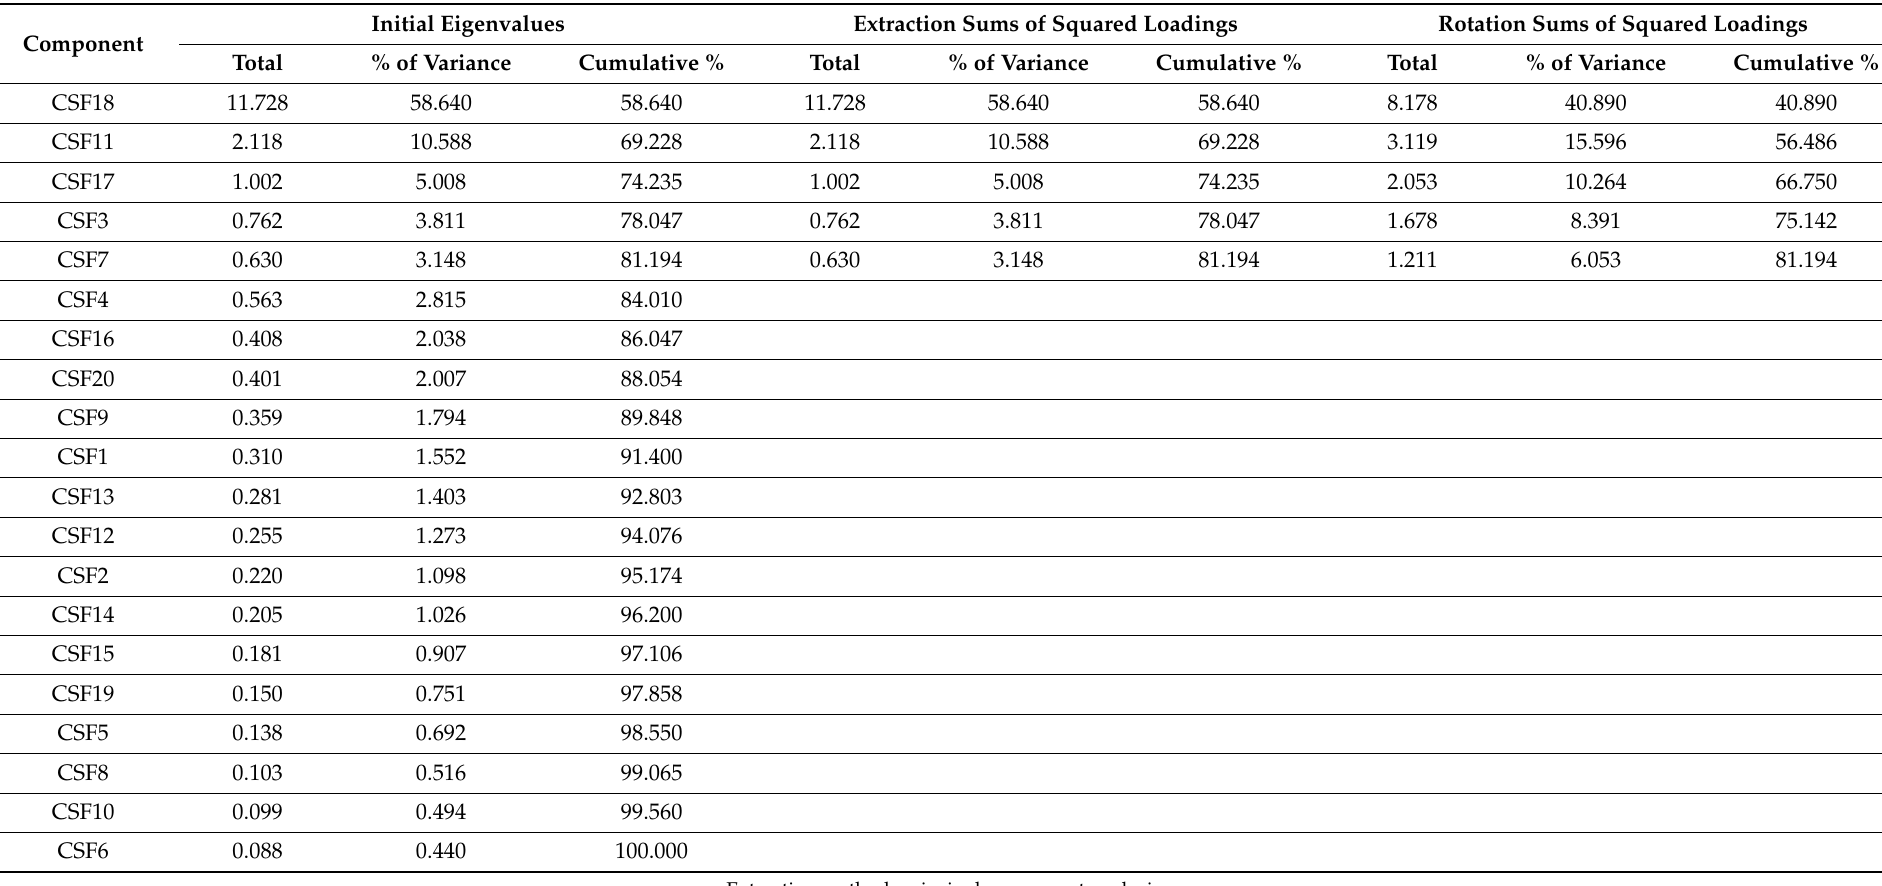
Table 3. Interpretation of total variance in the exploratory factor